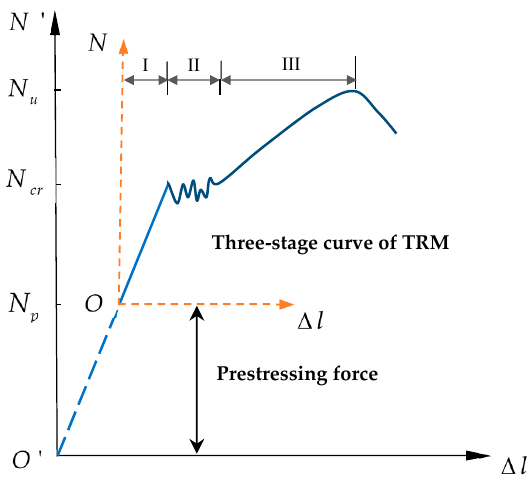
Figure 20. Influence of prestress on TRM.